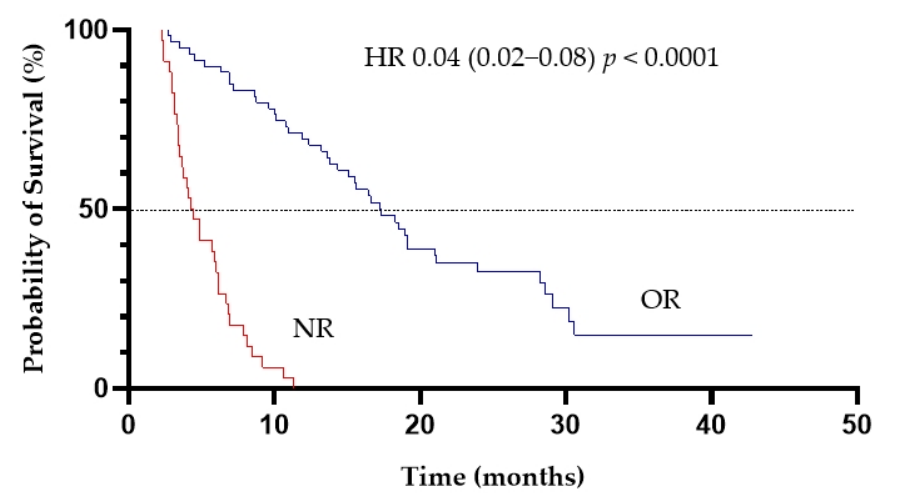
Figure 3. The effect of achieving an objective response (OR) to LD-AC+cladribine on overall survival (NR-no response).